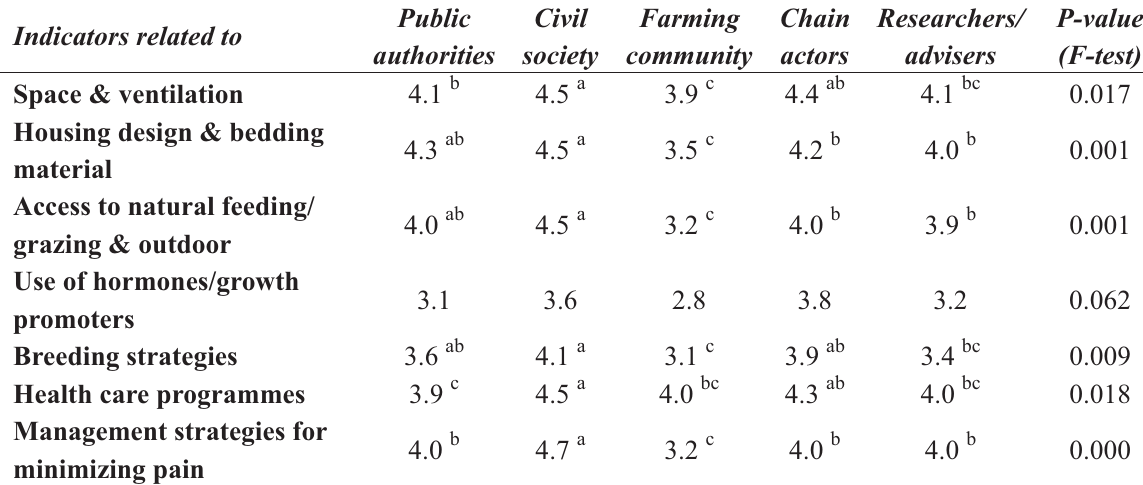
Table 7. Rating (1 to 5 scale 1 ) of the effectiveness of farm-level indicators according to each Expert category (means) (source: